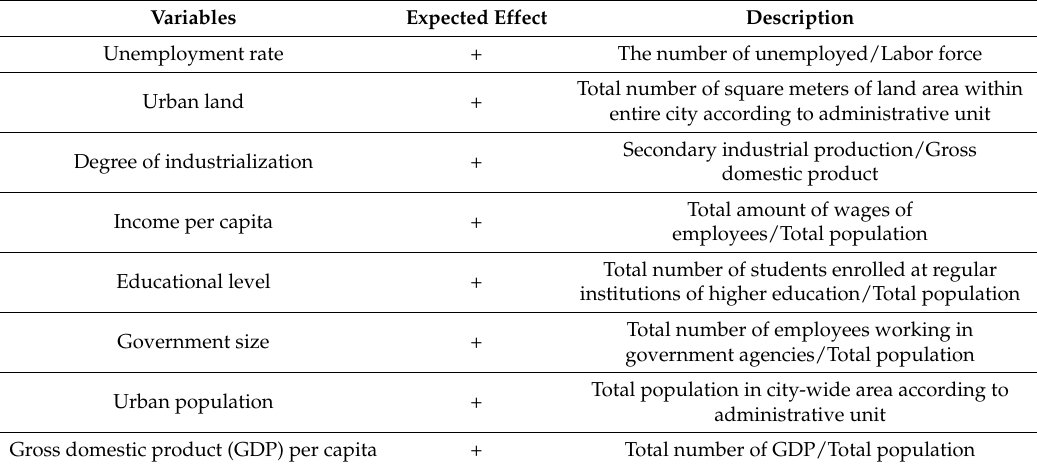
Table 3. Expected influence of the control variables on public services